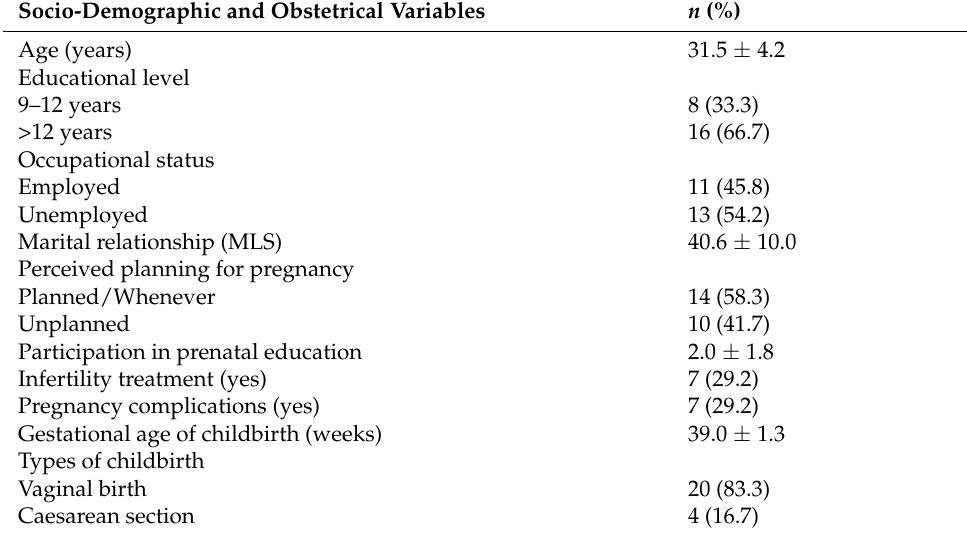
Table 1. Socio-demographic and obstetrical characteristics ( n =